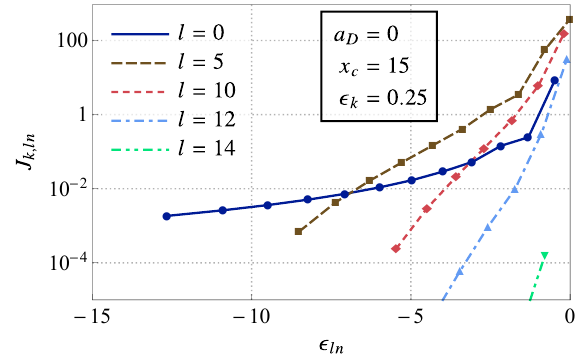
Figure 7. J k;ln as a function of (cid:15) ln for x c = 15 and (cid:15) k = 0 : 25. The lines correspond to di(cid:11)erent values of l